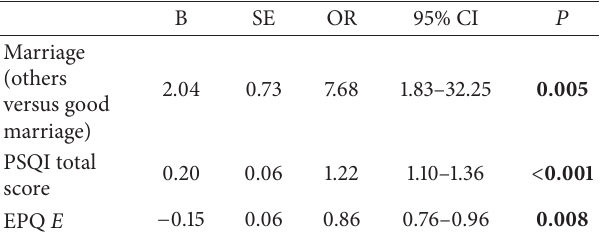
Table 3: The multivariate logistic regression model of the influence factors of FD